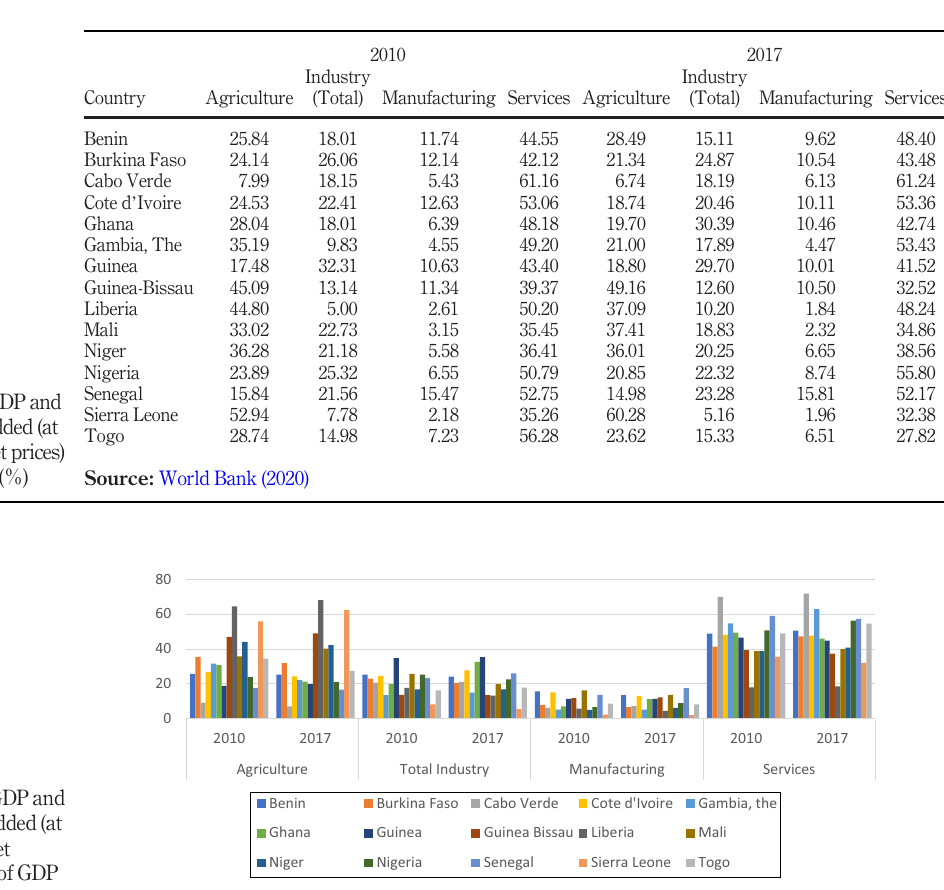
Figure 2. Structure of GDP and gross value added (at current market prices) Share of GDP